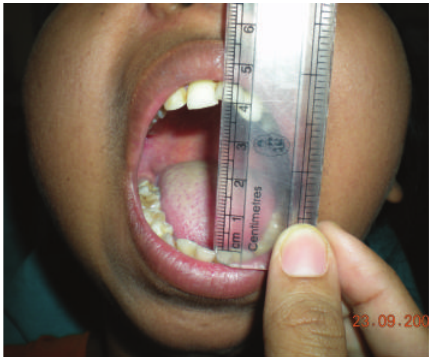
Figure 3: 3 months after surgery mouth opening increased up to 4cm.